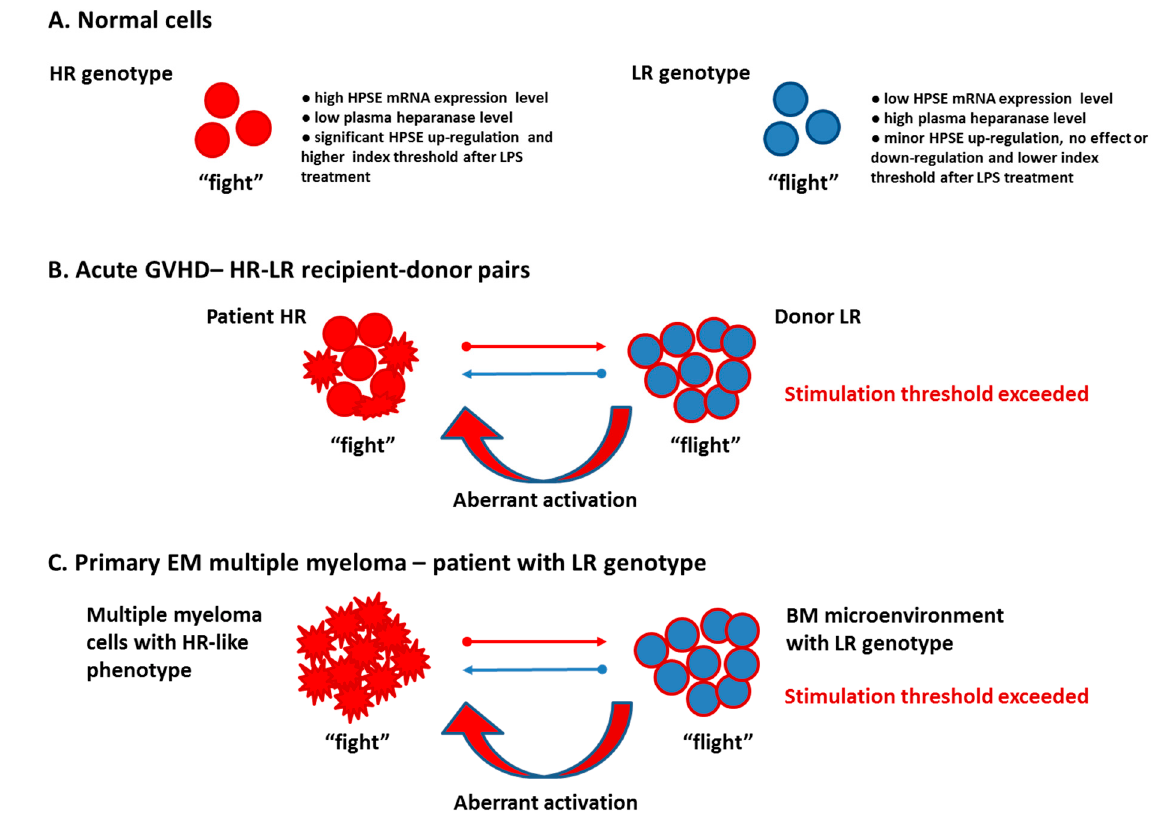
Figure 3. Scheme describing the putative role of discrepancy in HPSE SNP profiles as possible mech- anisms for the development of acute GVHD and primary paraskeletal disease in multiple myeloma. ( A ). Effect of enhancer (rs4693608) and insulator (rs4364254) HPSE gene SNP combinations on hep- aranase expression in normal cells. ( B ). Proposed influence of HPSE gene SNP discrepancy between patient and donor on the development of acute GVHD following HSCT. ( C ). Discrepancy between myeloma and microenvironment signaling dictates an increased risk of developing paraskeletal dis- ease in patients with the HPSE LR genotype (rs4693608-rs4364254 SNP combination).